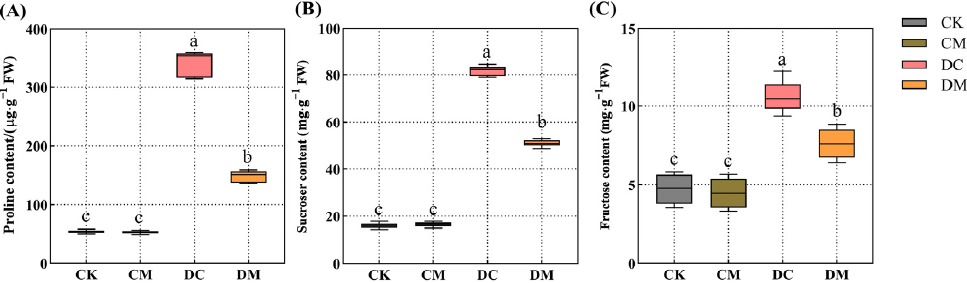
Figure 5. Effect of exogenous melatonin on proline, sucrose, and fructose contents under drought stress. ( A ) Proline content; ( B ) Sucrose content; and ( C ) Fructose content.